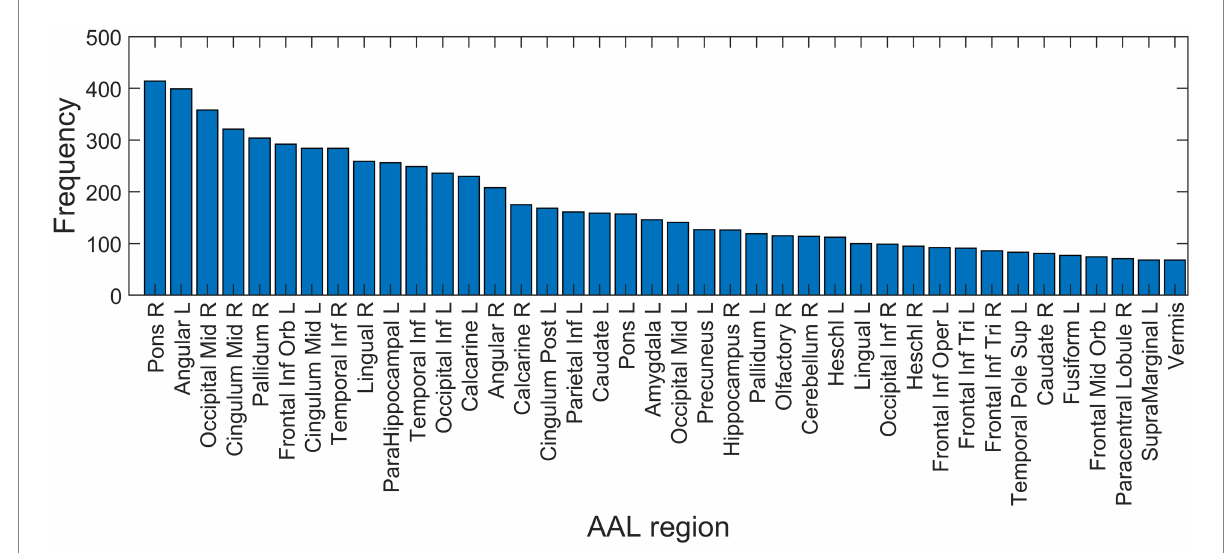
FIGURE 6 Feature selection frequency histogram of 40 most important features. Feature selection was performed on training set in each iteration using neighborhood component analysis (NCA), identifying the best non-zero lambda value corresponding to the minimum average loss. AAL, automated anatomic labeling; L, left; R,